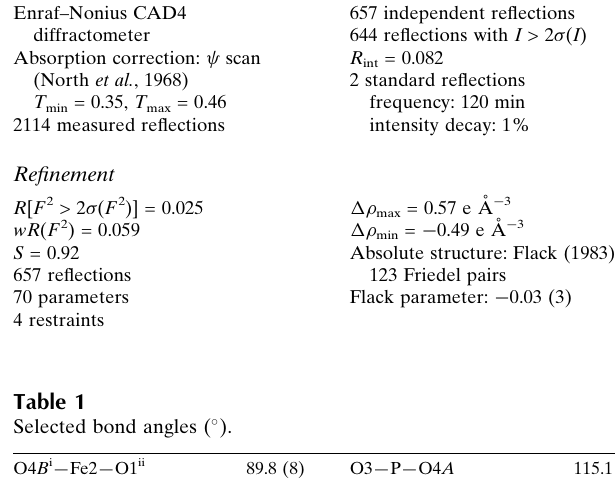
Selected bond angles ( (cid:3)